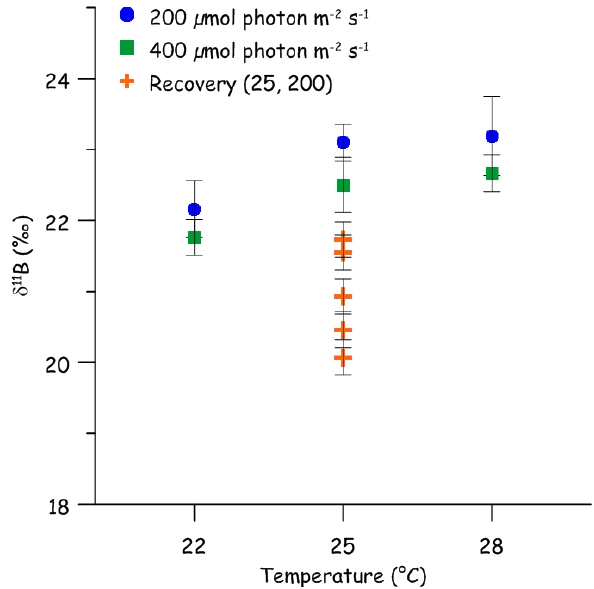
Fig. 3. Mean δ 11 B (‰) measured at the end of step 2 on corals grown under 200 (blue dots) and 400 (green squares) µmolphotonm − 2 s − 1 , plotted vs. temperature ( ◦ C). Orange crosses represent measurements performed at the end of step 3 (recovery experiment).